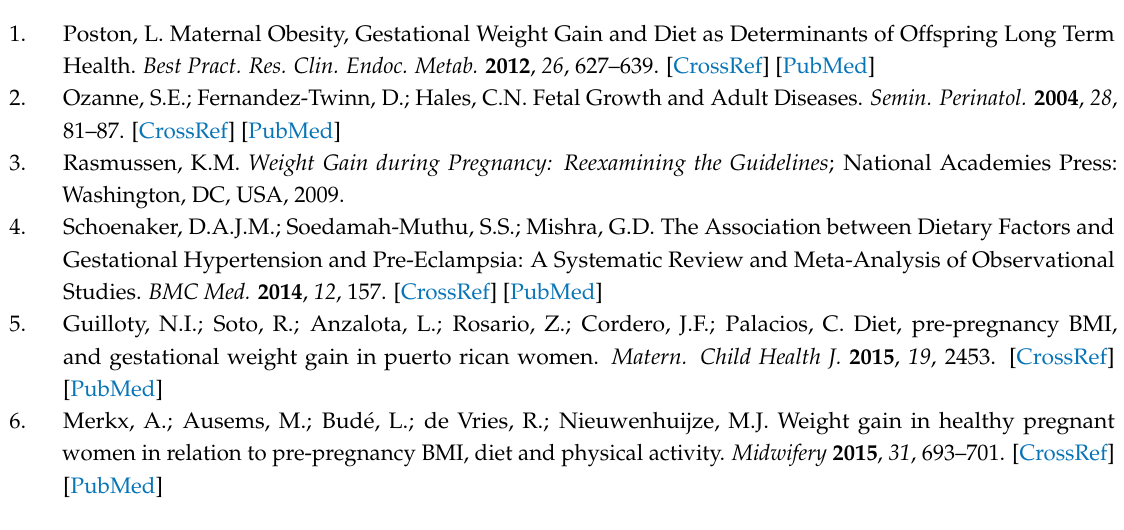
Table S1: Food groups and the FFQ items included in them, Table S2: Associations with gestational diabetes, Table S3: Associations with gestational weight gain (GWG) in excess of the IOM guidelines (compared with GWG within the IOM guidelines), Table S4: Sensitivity analysis showing relationship between ethnicity and dietary pattern scores with and without the individual ethnic groups in the non-Caucasian category associated with the